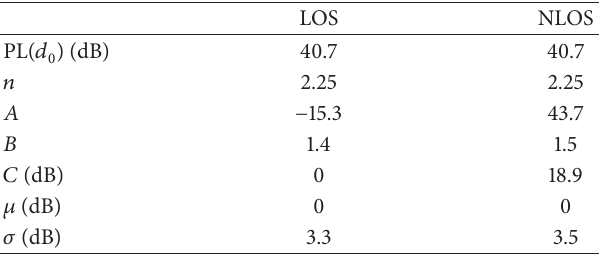
Table 2: Parameters of the proposed path loss model.